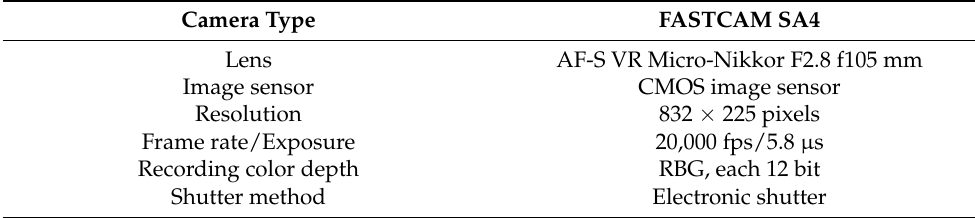
Figure 7. The optical system configuration. Table 4. Specifications of the high-speed camera and optical settings.